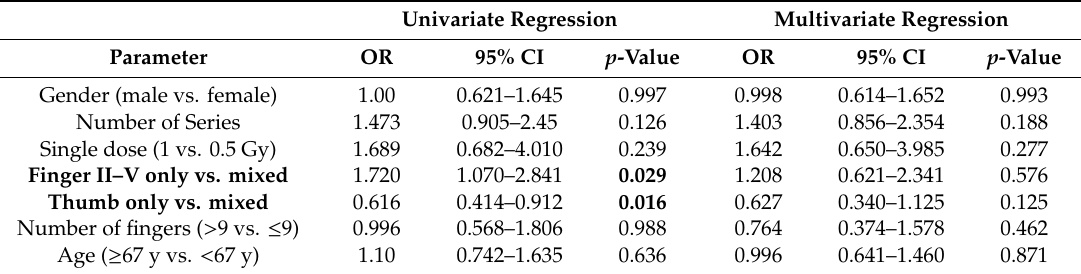
Table 1. Univariate and multivariate logistic regression analyzing the clinical factors influencing the treatment success following